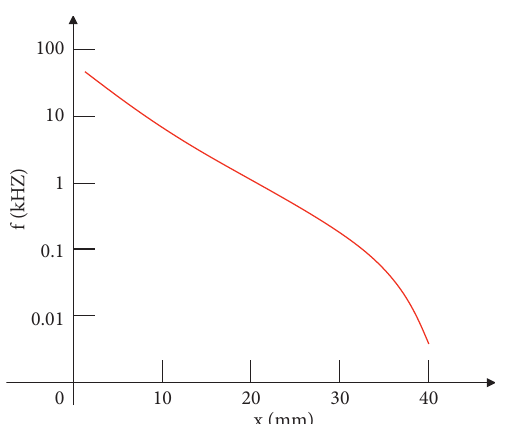
Figure 1: Relationship curve between characteristic frequency f and basement membrane position x